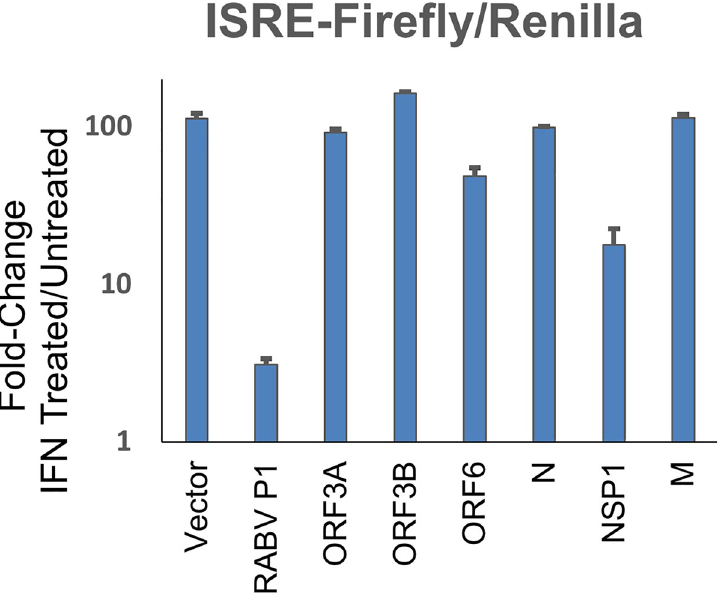
Fig 7. ISRE-luciferase promotor activation inhibition by SARS-CoV-2 genes. HEK-293T cells were transfected with pRL-TK (Renilla normalization control vector), pISRE-luciferase and viral plasmids to express the indicated viral protein or empty pUC-18 vector. The rabies virus phospho-protein–RABVP1 served as positive control. 24 hours post transfection cells were treated for 8 hours with 1000U/ml IFN α before cells were lysed and analysed by dual luciferase assay. Data shown are of the ratio of IFN-treated / untreated cells calculated from normalised luciferase activity (Firefly/Renilla) for each given viral gene. The data (average values ± SEM) is representative of three independent